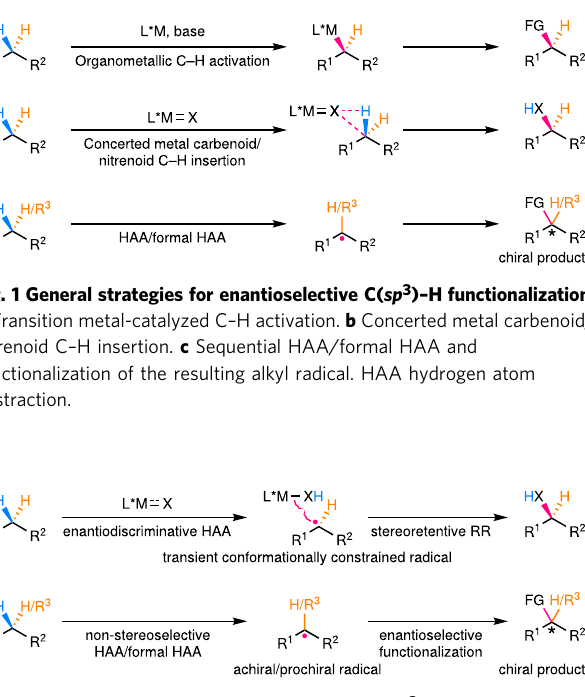
Fig. 2 Two catalytic modes of enantioselective C( sp 3 ) – H functionalization reactions via radical intermediates. a Enantiodiscriminative HAA coupled with fast stereoretentive RR. b Non-stereoselective HAA/formal HAA followed by enantioselective functionalization of the resulting prochiral/ achiral radical. RR radical rebound.